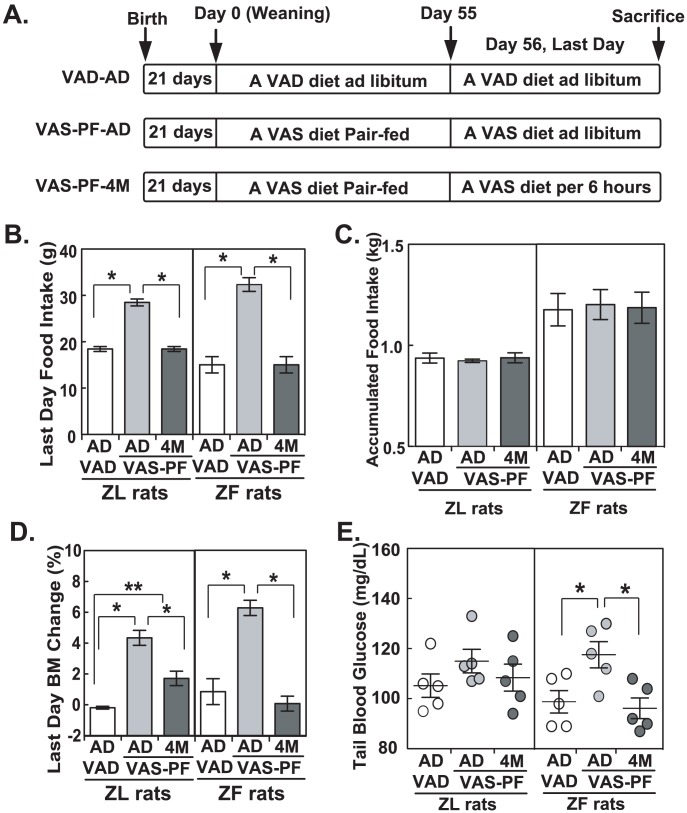
VAS-PF-AD ZL and ZF overate on the last day when sufficient VAS diet was provided.(A) The schematic graph of the setup for the pair-feeding regimen. VAD ad libitum (VAD-AD, n = 5), VAS pair-feeding last day ad libitum (VAS-PF-AD, n = 5), VAS pair-feeding last day 4 meals (VAS-PF-4M, n = 5) (B) Tail tip whole blood glucose from ZL and ZF rats before sacrifice. Each circle represents a value from an individual animal. The bars represent mean ± S.E.M. * Indicates p<0.05 using one-way ANOVA with LSD post-hoc test. (C) The accumulative food intake for ZL and ZF rats over 56 days of pair-feeding regimen. (D) The food intake and (E) body mass change for ZL and ZF rats on day 56 of the pair-feeding regimen. * Indicates p<0.05 using one-way ANOVA with LSD post-hoc test.